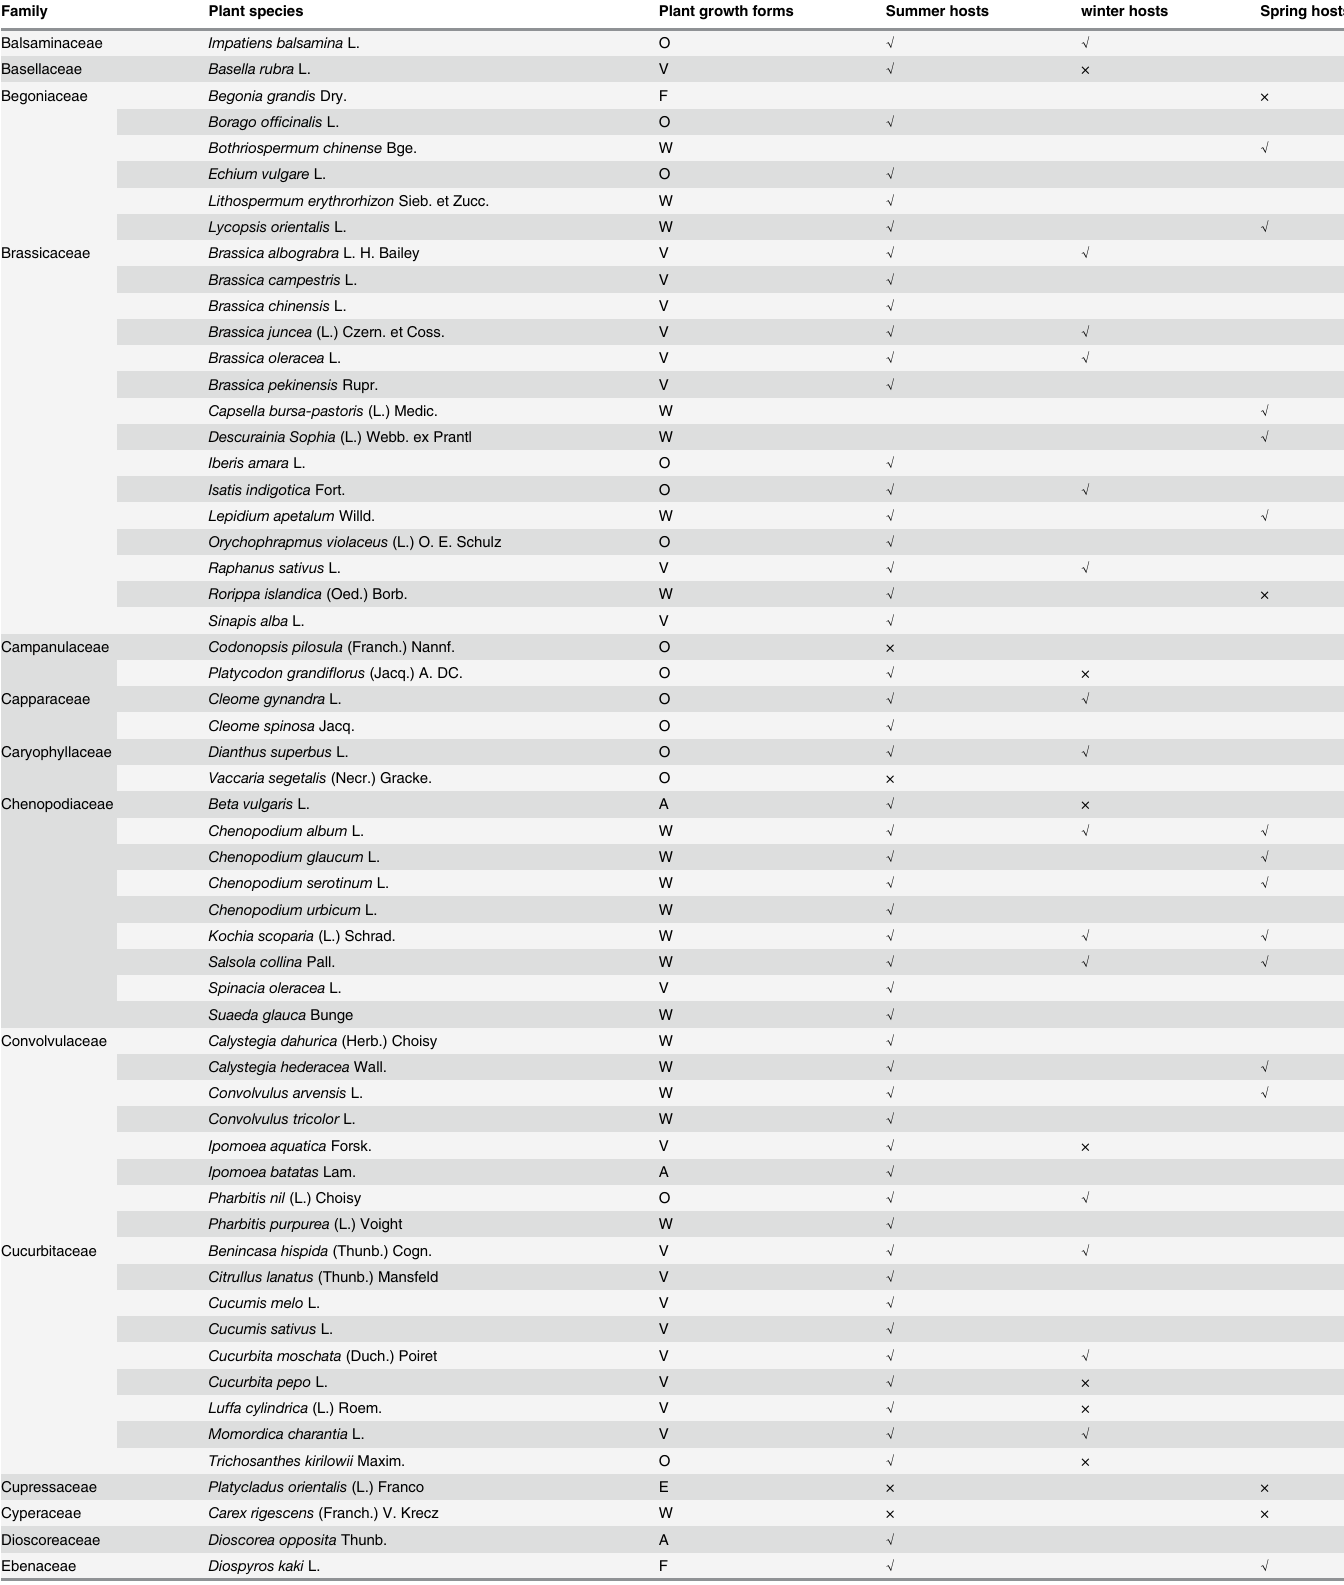
Luffa cylindrica (L.) Roem. Momordica charantia L.